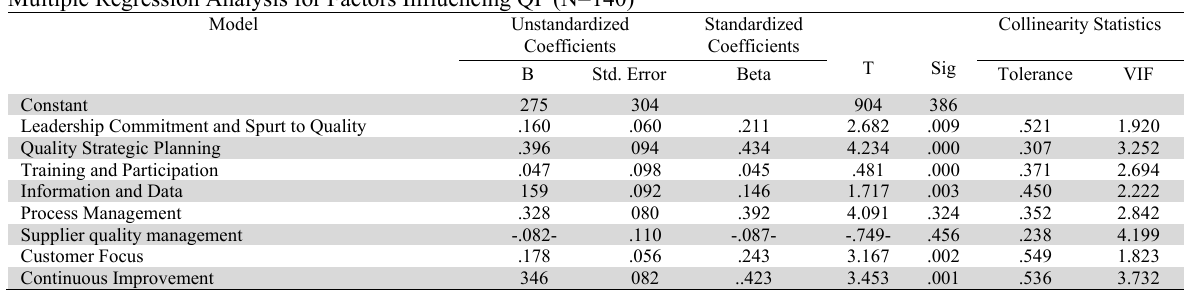
Multiple Regression Analysis for Factors Influencing QP (N=140)